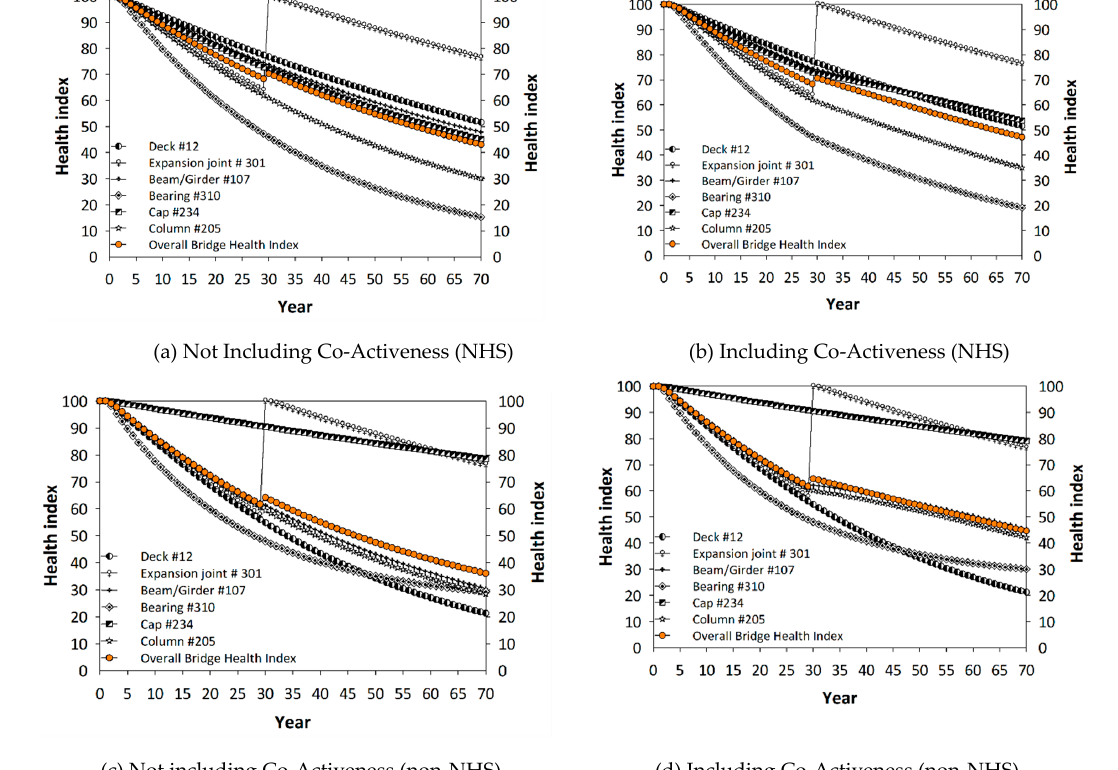
Figure 10. The effect of an expansion joint replacement not including and including the co-active mechanism: ( a ) and ( b ) in NHS Bridges, ( c ) and ( d ) in Non-NHS bridges in Virginia.